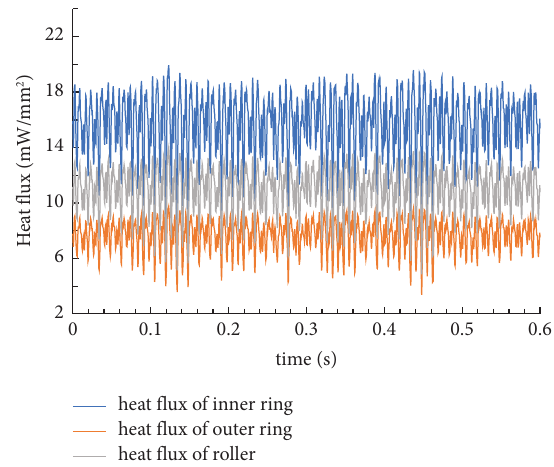
Figure 4: Heat fux applied on bearing.